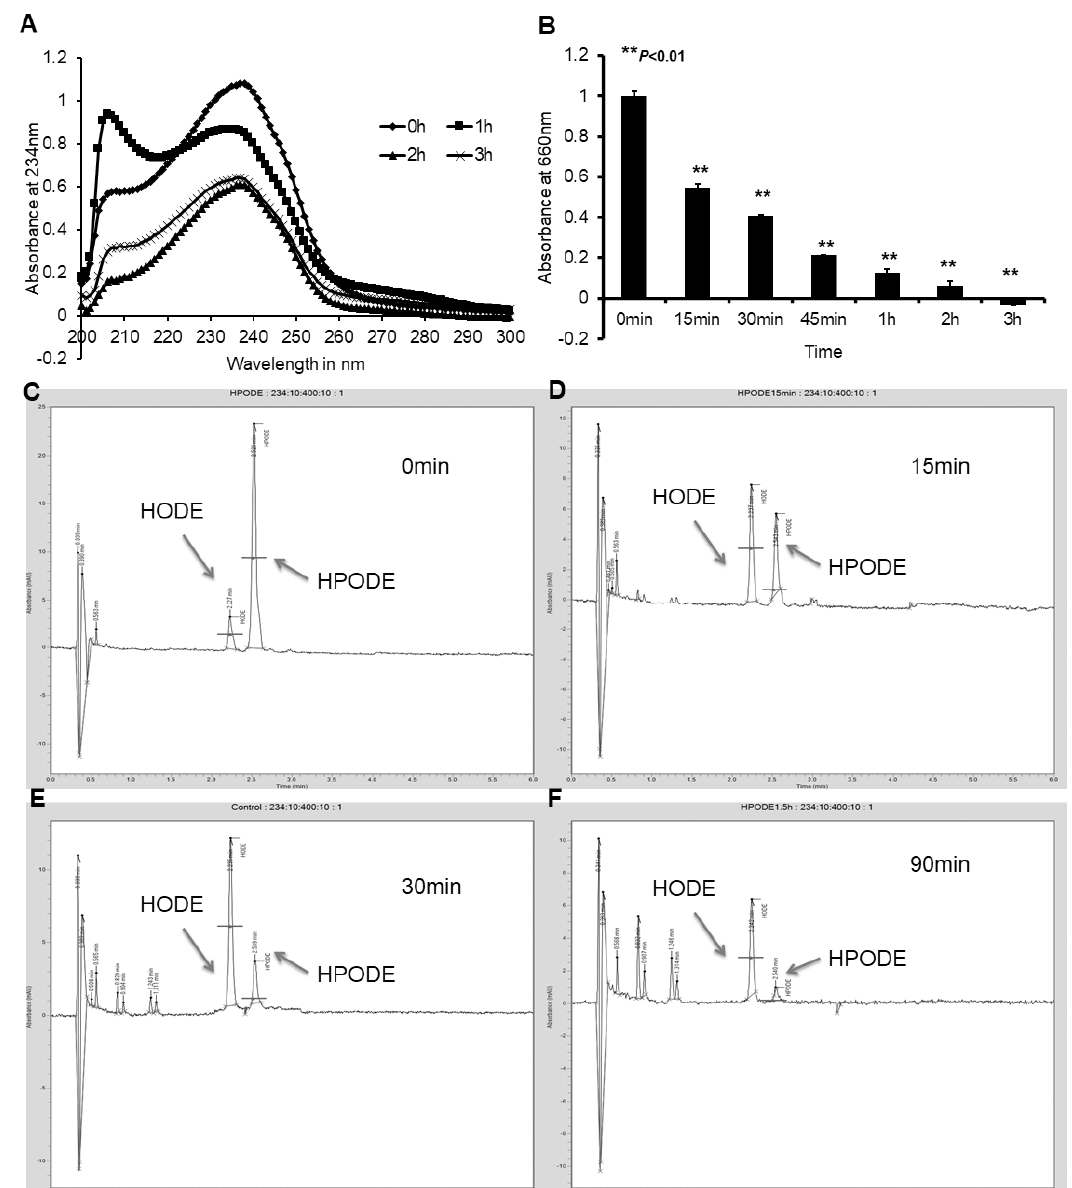
Figure 1. Lipid peroxides are reduced to hydroxides in the presence of fully differentiated Caco-2 cells: ( A ) 13-HPODE was incubated with differentiated Caco-2 cells, resulting in a decrease in cell media 13-HPODE dienes over 120 min; ( B ) decrease in Caco-2 cell media peroxides over time, as measured by LMB assay (** p < 0.01); ( C – F ) HPLC of Caco-2 cell media components, demonstrating a decrease in 13-HPODE and increase in 13-HODE peak AUC. Data represent 3 separate experiments, with n = 3/group/experiment.